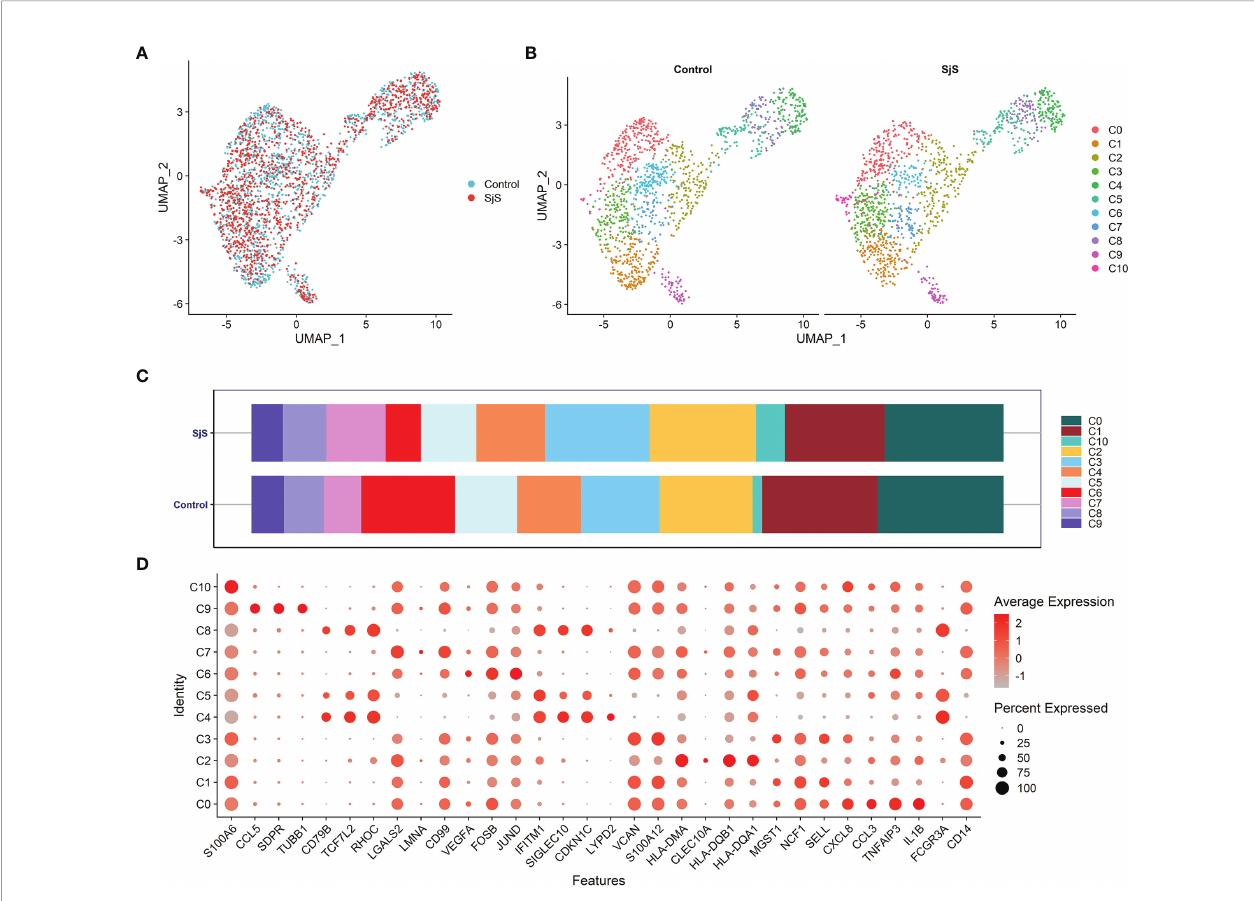
FIGURE 1 | Identi fi cation of monocyte subsets among SjS patients via scRNA-seq transcriptome analyses. (A) , Visualization of the distribution of monocytes between SjS patients and controls via the UMAP dimension reduction method. (B) , Visualization of clusters of monocytes between SjS patients and controls via the UMAP dimension reduction method. (C) , Comparison of the percentages of monocyte clusters between SjS patients and controls. (D) , Dot plot shows the expression percentages and the expression levels of feature genes of different clusters of